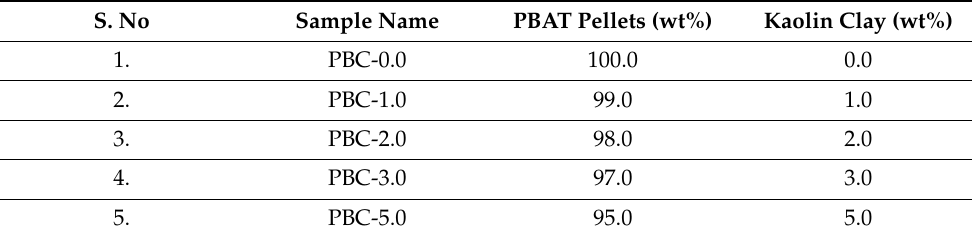
Figure 1. Fabrication diagram for PBAT/kaolin clay biocomposites. Table 2. Material formulation in blends and composite film preparation.